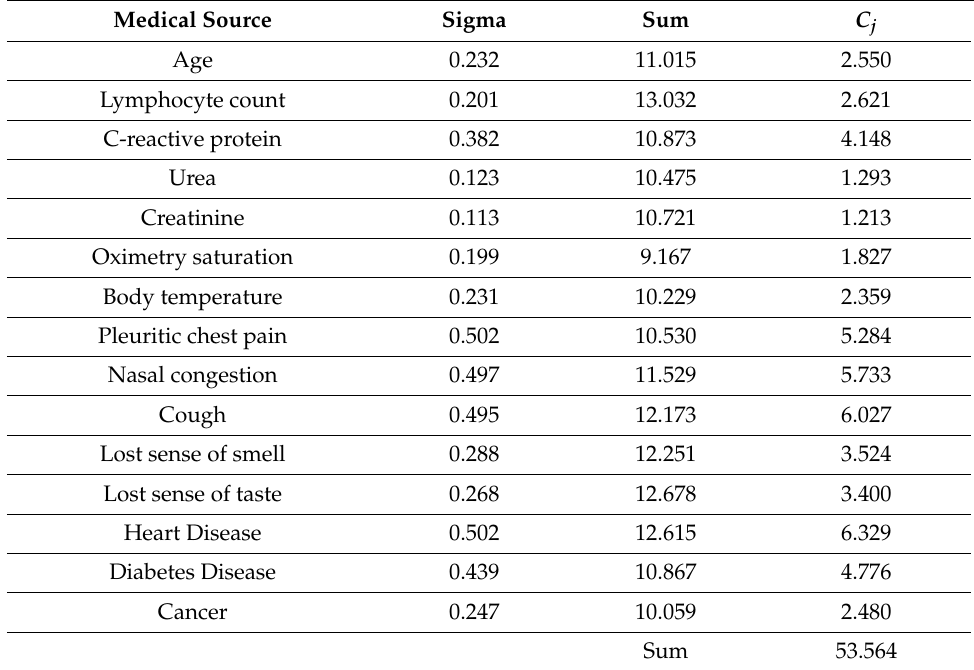
Table A3. The quantity of information ( C j